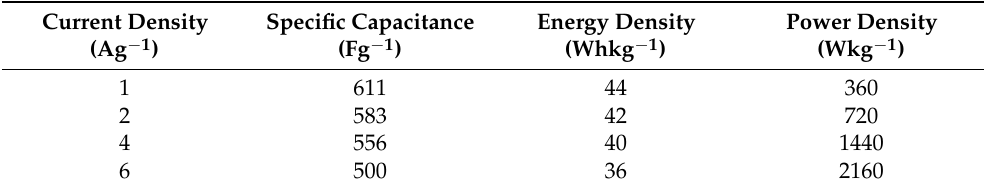
Table 2. Energy density and power density measured for the samples at different values of current densities for PANI:PEDOT/AC composite film deposition on ITO Glass.